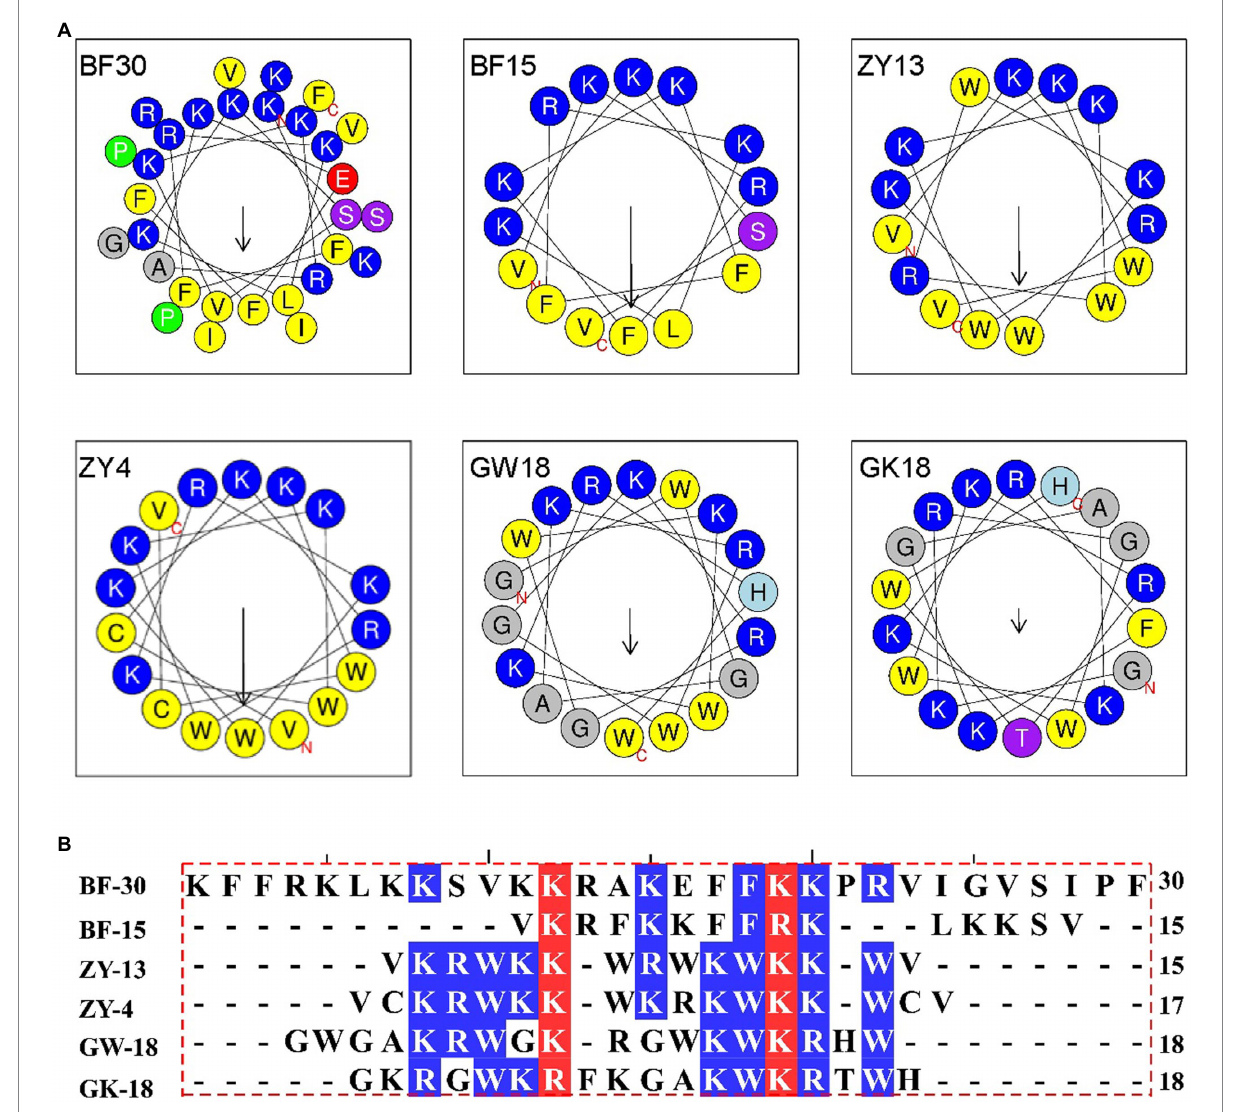
FIGURE 1 (A) Helical wheel projection diagrams of GW18 and other cathelicidin-BF analogs. The hydrophobic residues are presented in yellow color, positively charged hydrophilic residues blue, the noncharged polar residue purple, and negatively charged hydrophilic residue red. (B) The multiple sequence alignment analysis of these antimicrobial peptides were analyzed using DNAMAN software.